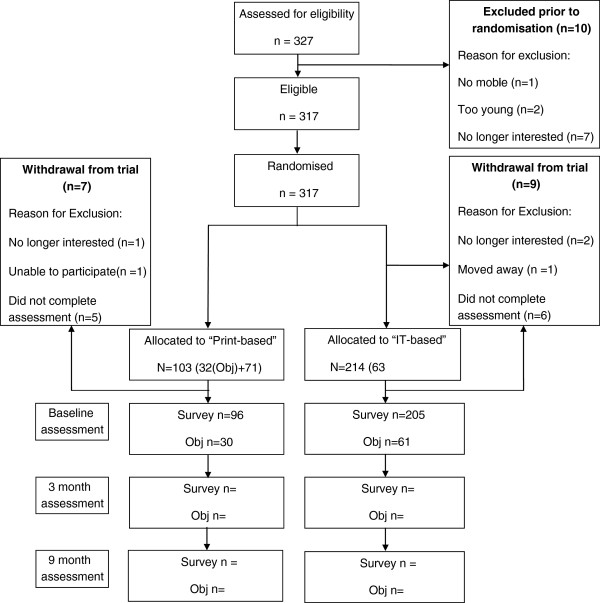
Flowchart describing the progress of participants through trial phases. Obj – Objective or ‘in person’ measurement completed with randomly selected sub-sample of participants.